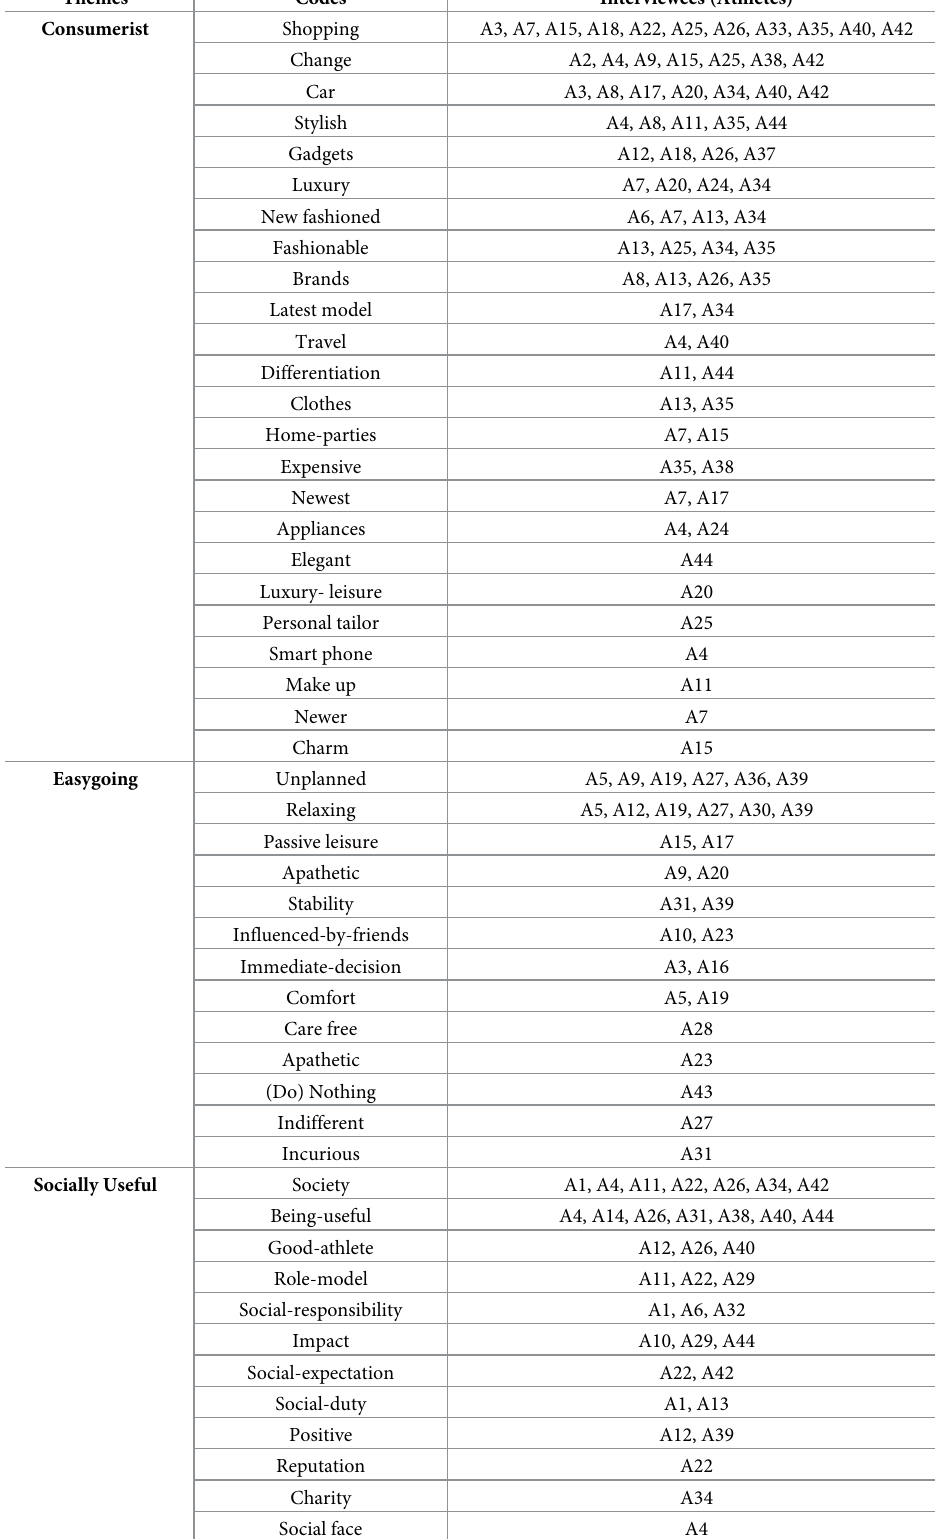
Table 4. Themes and emerged codes by participants